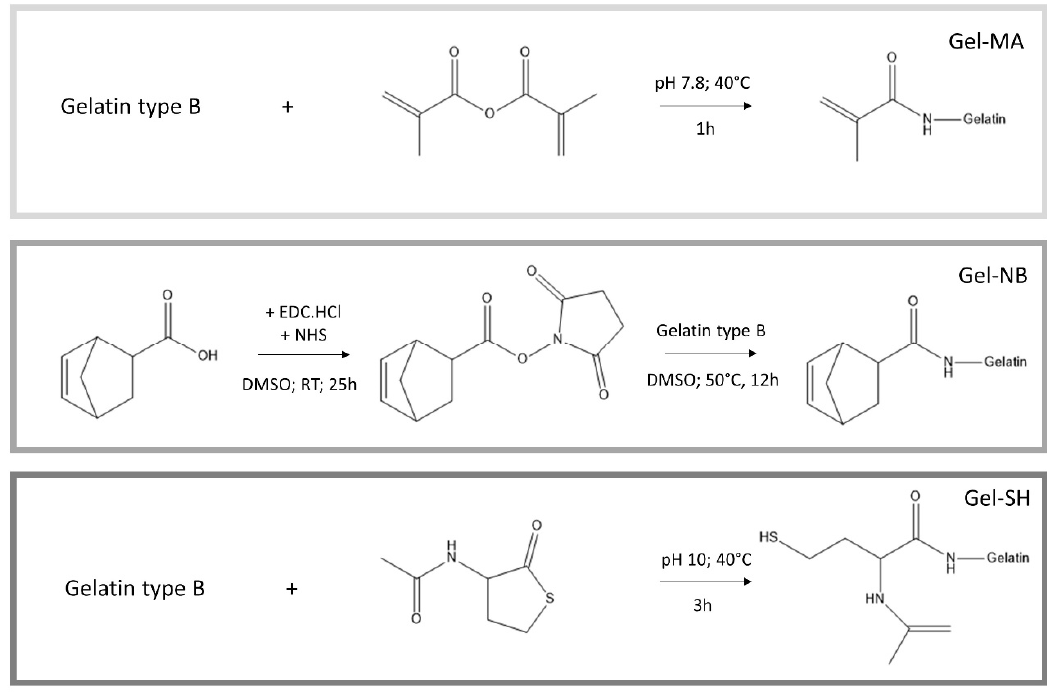
Figure 1. Reaction scheme depicting the development of gel-MA, gel-NB and gel-SH precursors. The crosslinked hydrogel films are obtained through chain growth polymerization for gel-MA and via step growth polymerization when gel-NB is combined with either DTT or gel-SH. DTT: 1,4-dithiotreitol; EDC: N-(3-dimethylaminopropyl)-N’-ethylcarbodiimide hydrochloride; gel-MA: methacrylated gelatin; gel-NB: norbornene-functionalized gelatin; gel-SH: thiolated gelatin; NHS: N-hydroxysuccinimide.